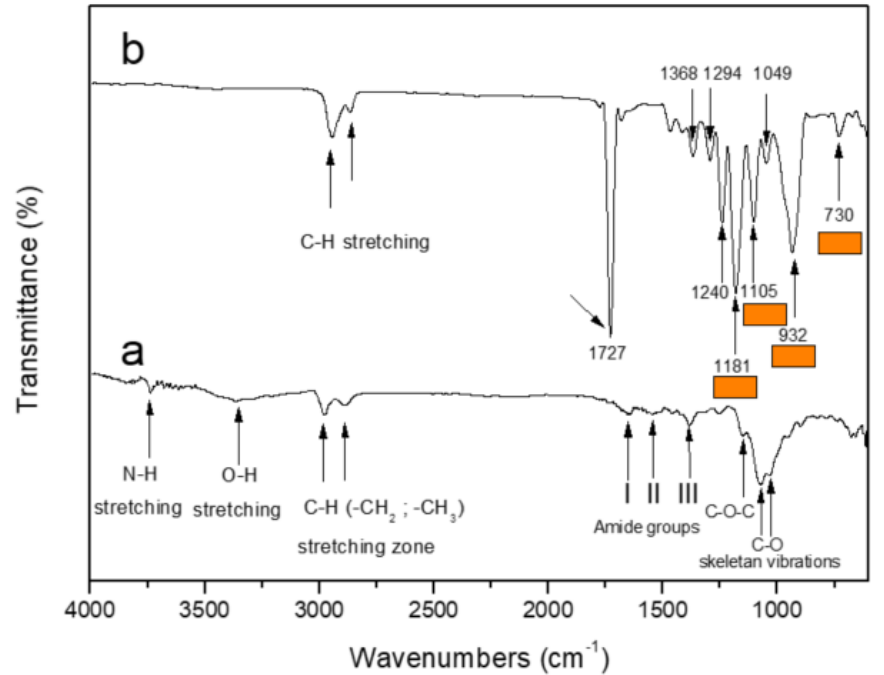
Figure 2. FTIR of ( a ) Chitosan powder and ( b ) ESM composed of R-chitosan fibers.